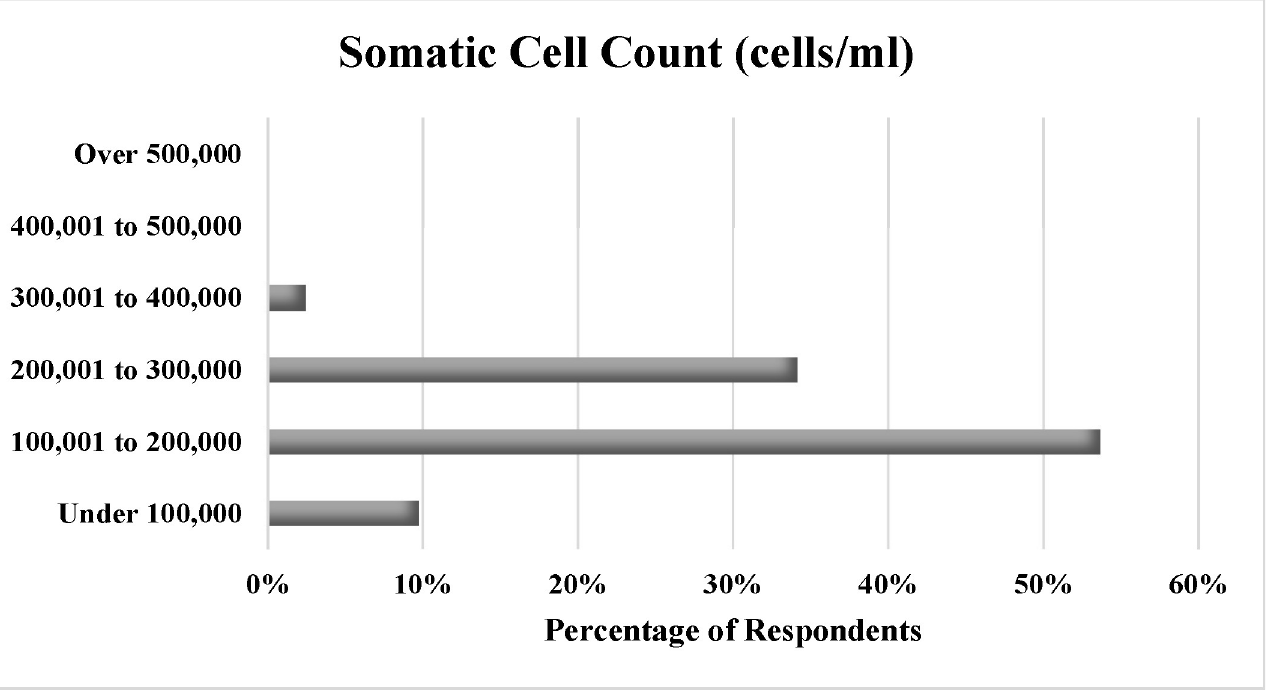
Fig 4. Percentage of respondents reporting each level of somatic cell